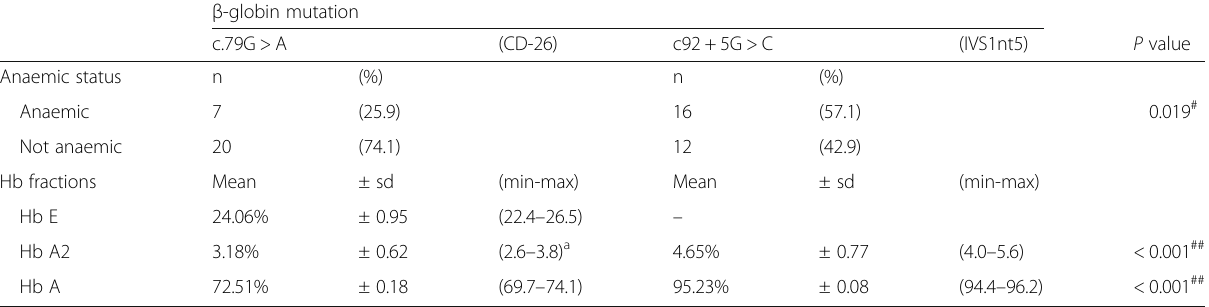
Table 1 Distribution of anaemia and Hb fraction analysis in association with β -globin gene mutations at c.79G > A (CD-26) and at c92 + 5G > C (IVS1nt5) among carrier thalassemia individuals from Bandung, Indonesia